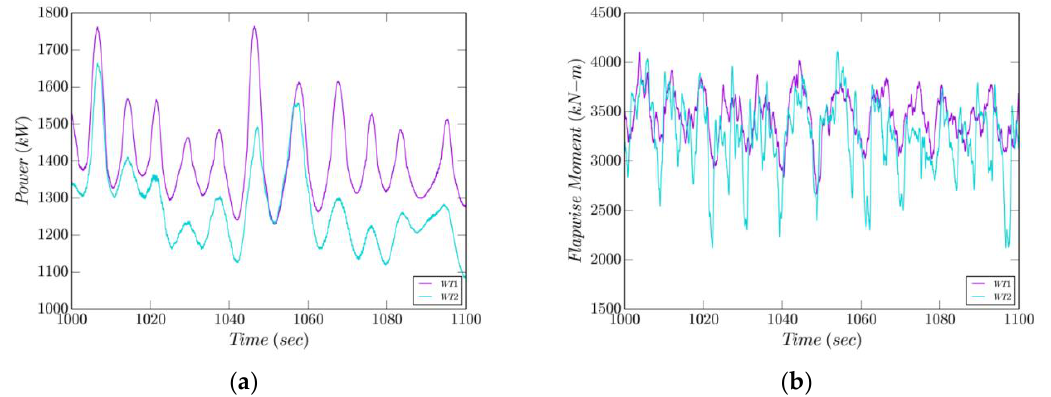
Figure 11. ( a ) Power and ( b ) flapwise blade root moment from SOWFA (Simulator fOr Wind Farm Applications) in which WT2 is offset by −1D.